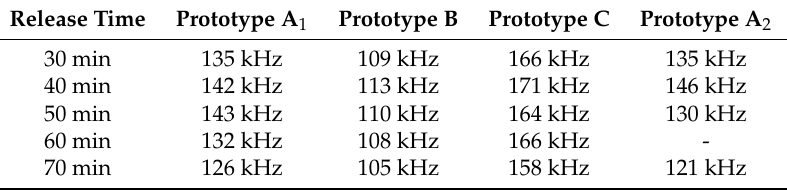
Table 1. Release time versus average resonance frequency measured from ten dice.